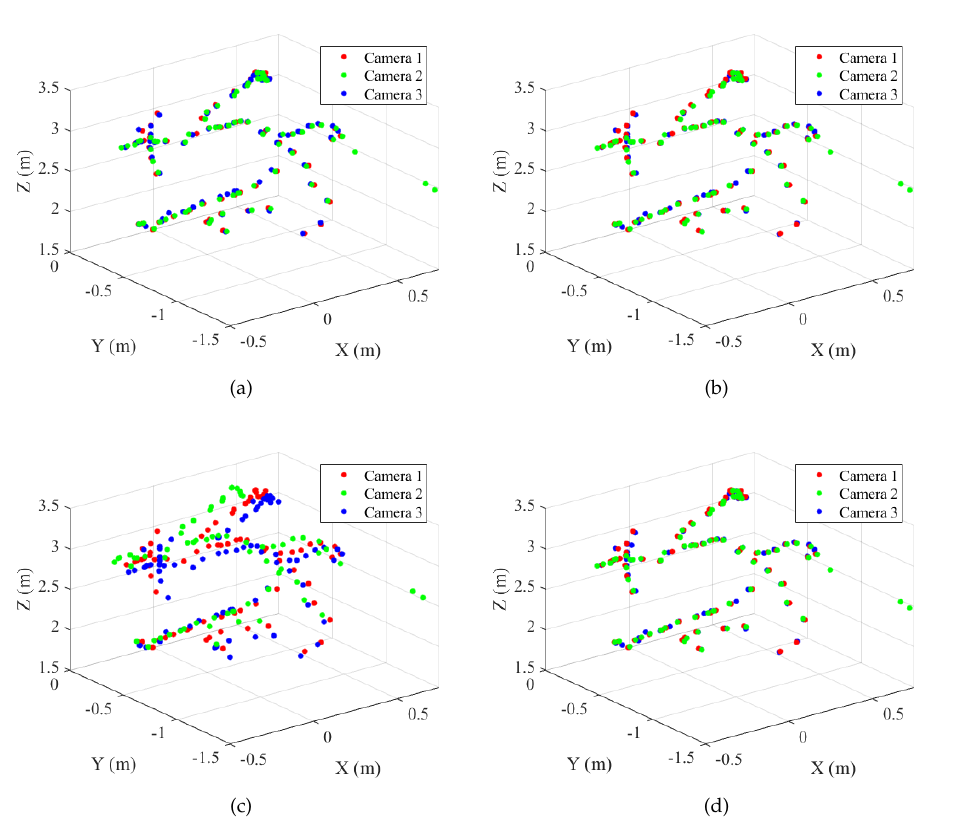
Figure 15. Aligned sphere centers (dynamic set, N = 164). ( a ) Proposed method (pairwise). ( b ) Proposed method (BA). ( c ) Su et al. [20]. ( d ) Su et al. [20] (inlier set). Refer to the text for more detail. Best viewed in